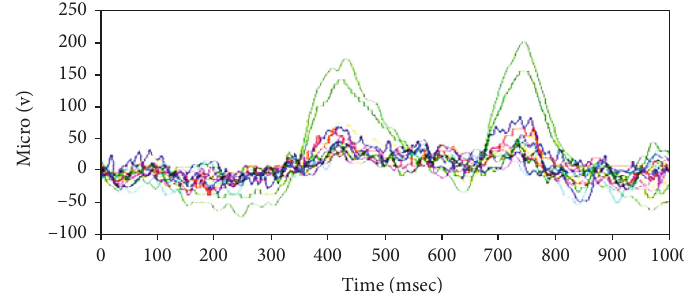
Figure 4: Time series for subject during the fi rst second with open